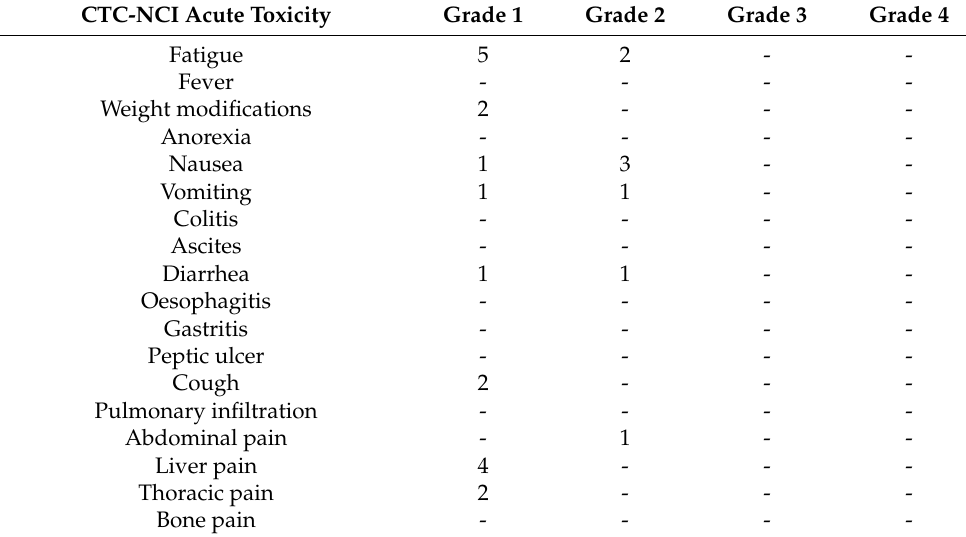
Table 3. CTC-NCI v3.0 acute toxicity ( ≤ 3 months after treatment). A patient may present several symptoms ( N = 43 patients).